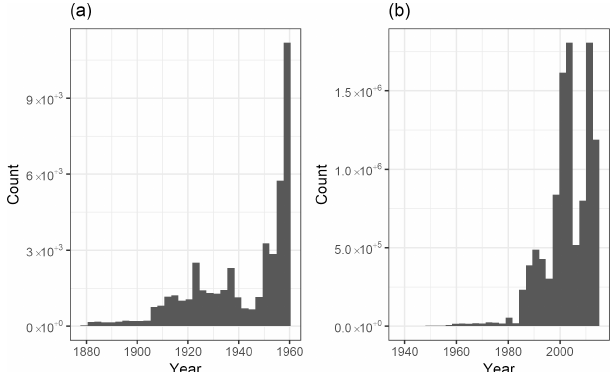
Figure 5. Illustration of data coverage with time: (a) 1880–1956 and (b) 1957–2014 (note the order of magnitude differences in